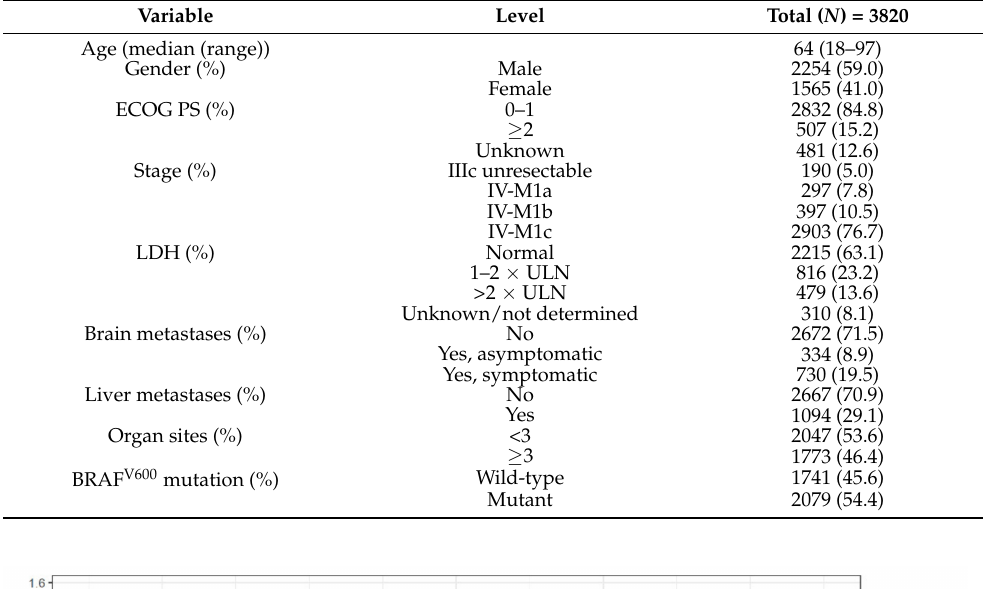
Table 1. Patient and tumor characteristics of patients diagnosed between 2013 and 2017. If ≥ 5% of data are missing for a variable, this is indicated by the category “unknown”.